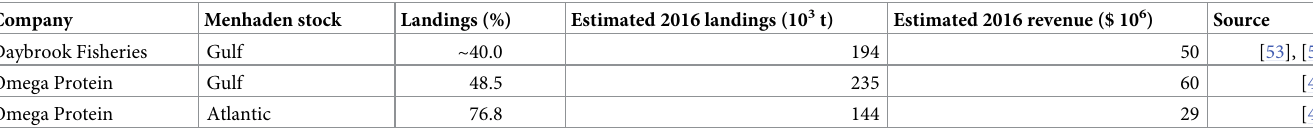
Table 6. Major menhaden fishing companies in the United States of America. Company